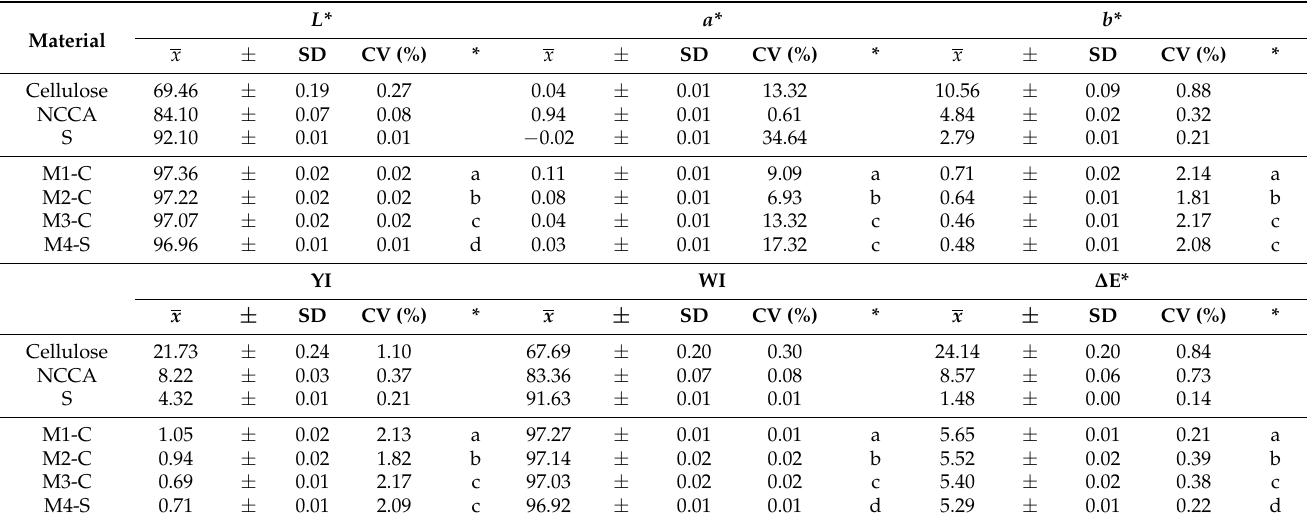
Figure 4. Main effects for ( a ) a w , ( b ) yellowness index, ( c ) whiteness index, ( d ) transparency, ( e ) traction. Table 3. Color L*, a*, b* , YI, and WI of raw material and